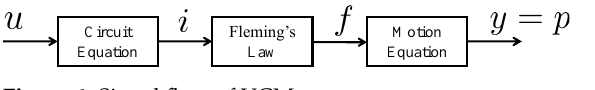
Figure 6. Signal flow of